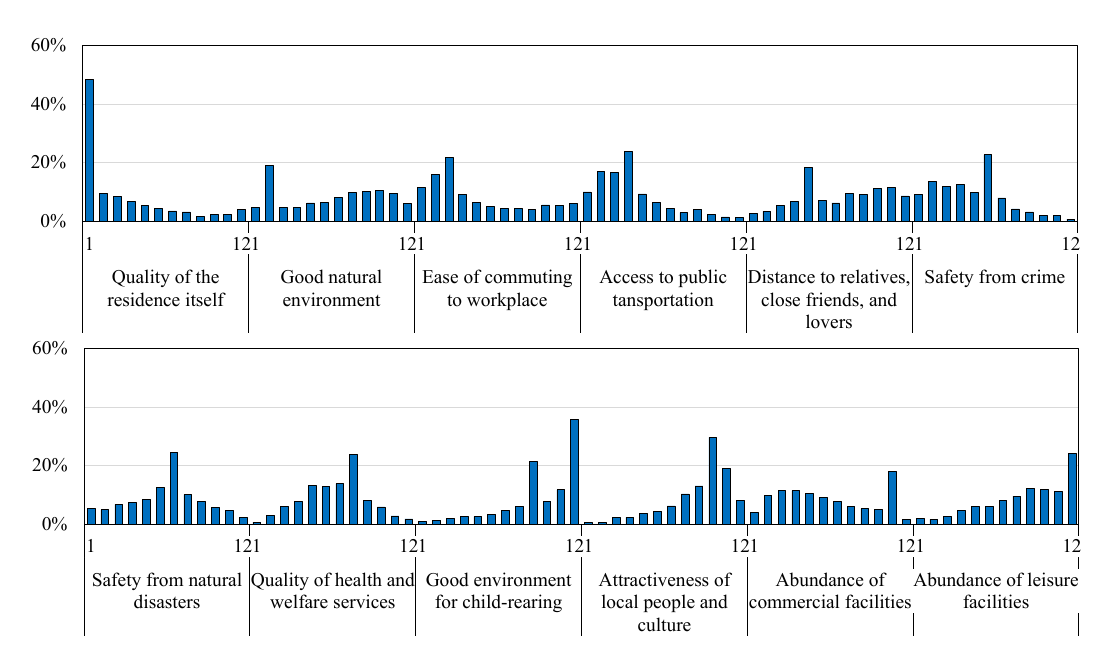
Figure 2. Ranking of factors influencing residential preferences amongst respondents ( n = 1554). A value of 1 indicates highest preference, and 12 the lowest.